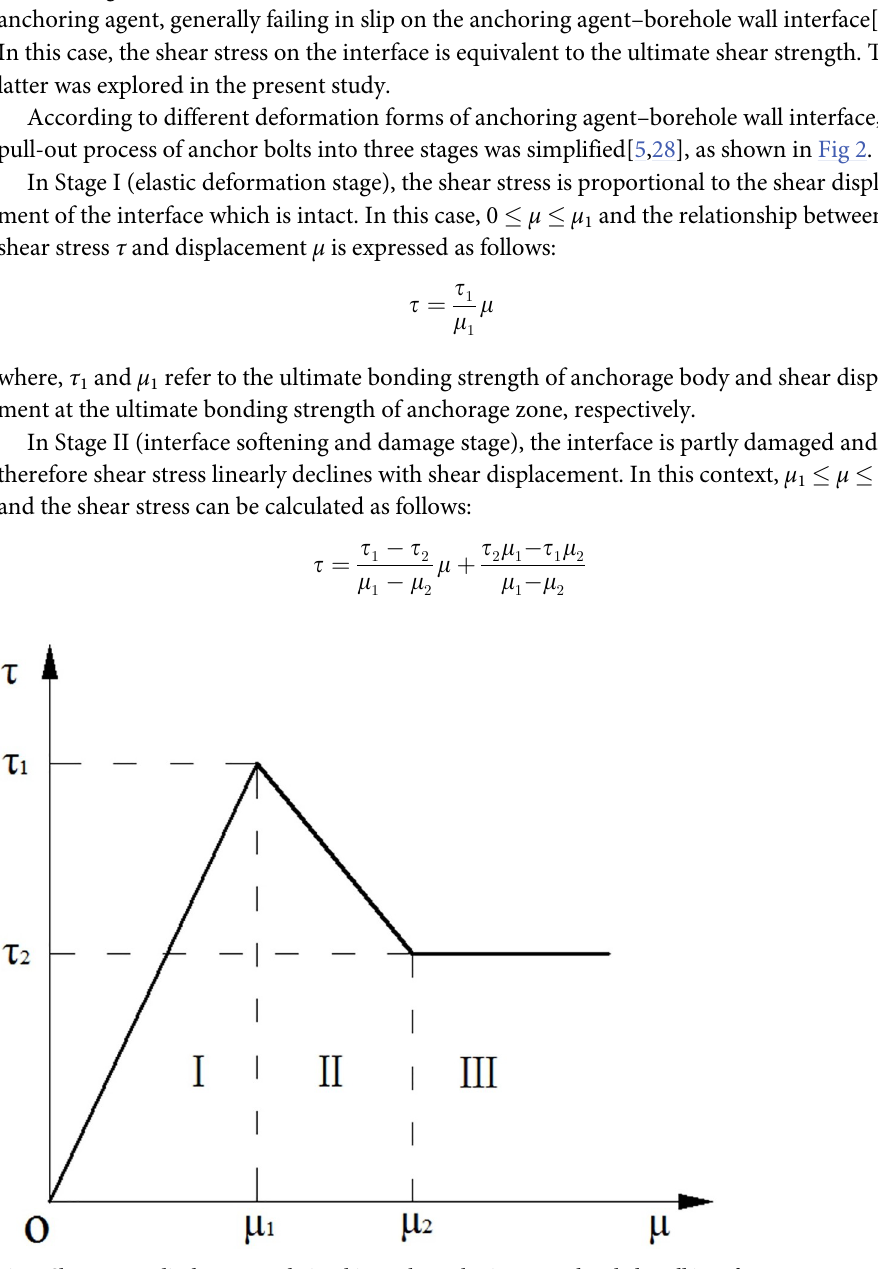
Fig 2. Shear stress–displacement relationship on the anchoring agent–borehole wall